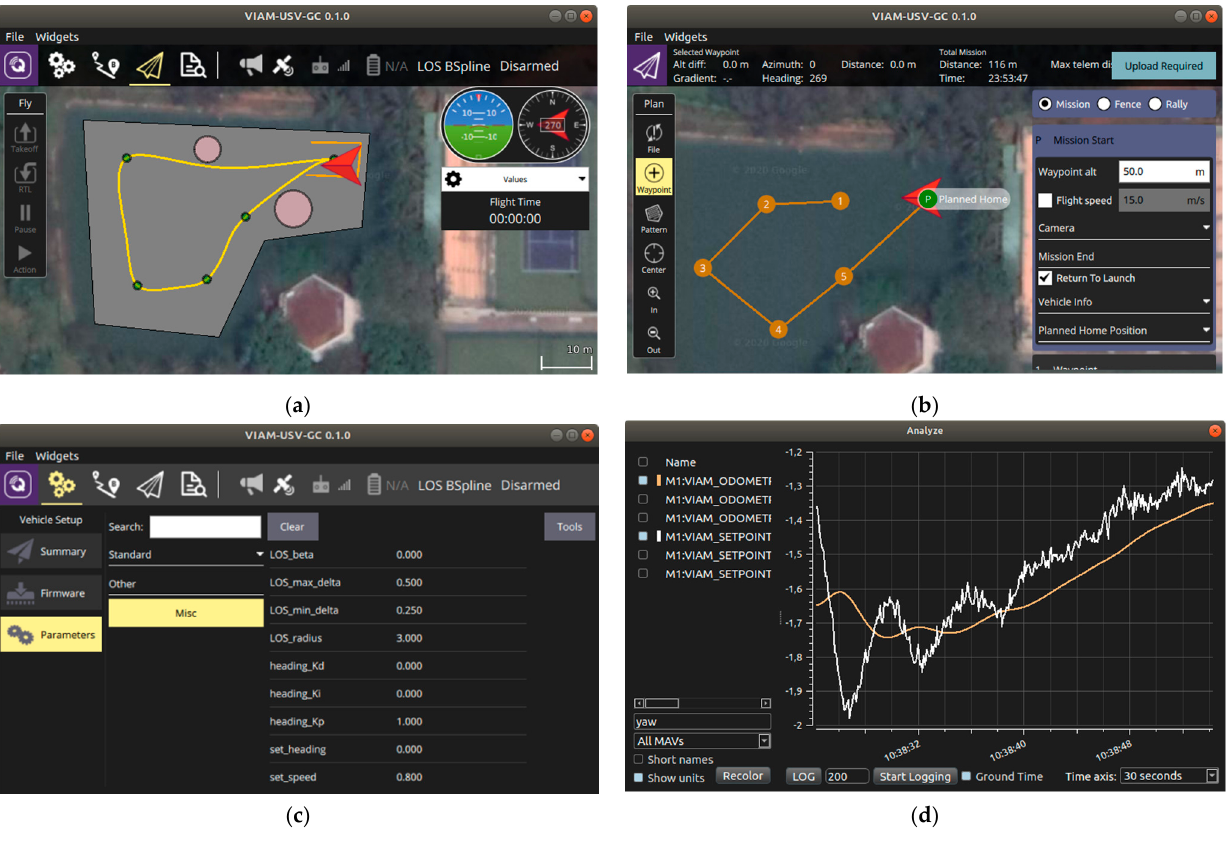
Figure 4. Functionalities of VIAM-USV-GC: itinerary monitoring ( a ), mission planning ( b ), parameter tuning ( c ) and real-time data plotting ( d ).